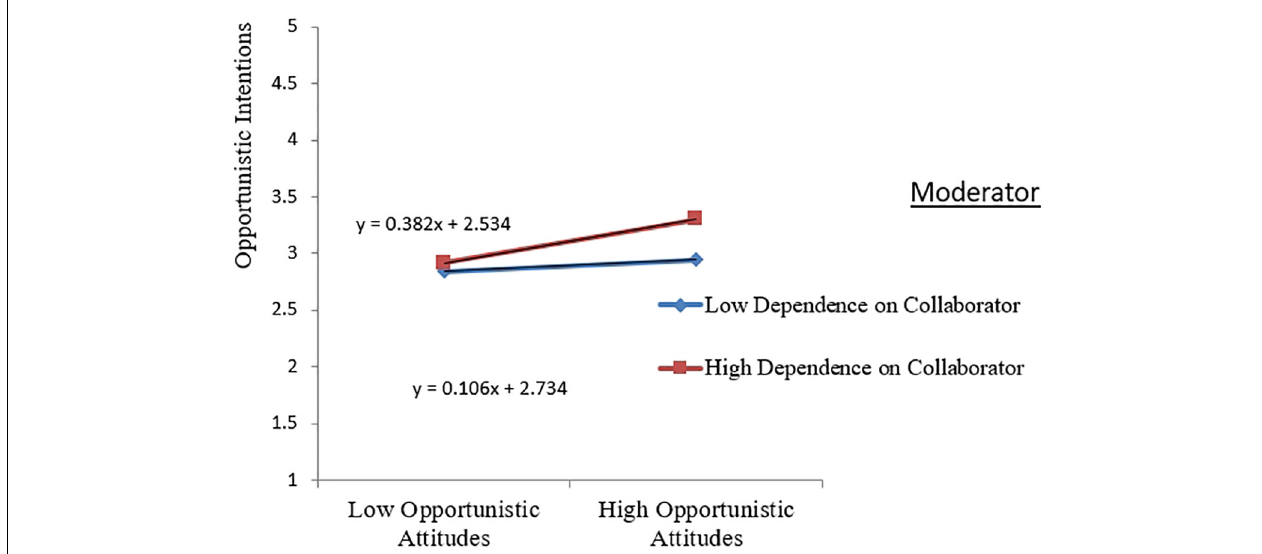
FIGURE 3 | Moderating effect of dependence on the